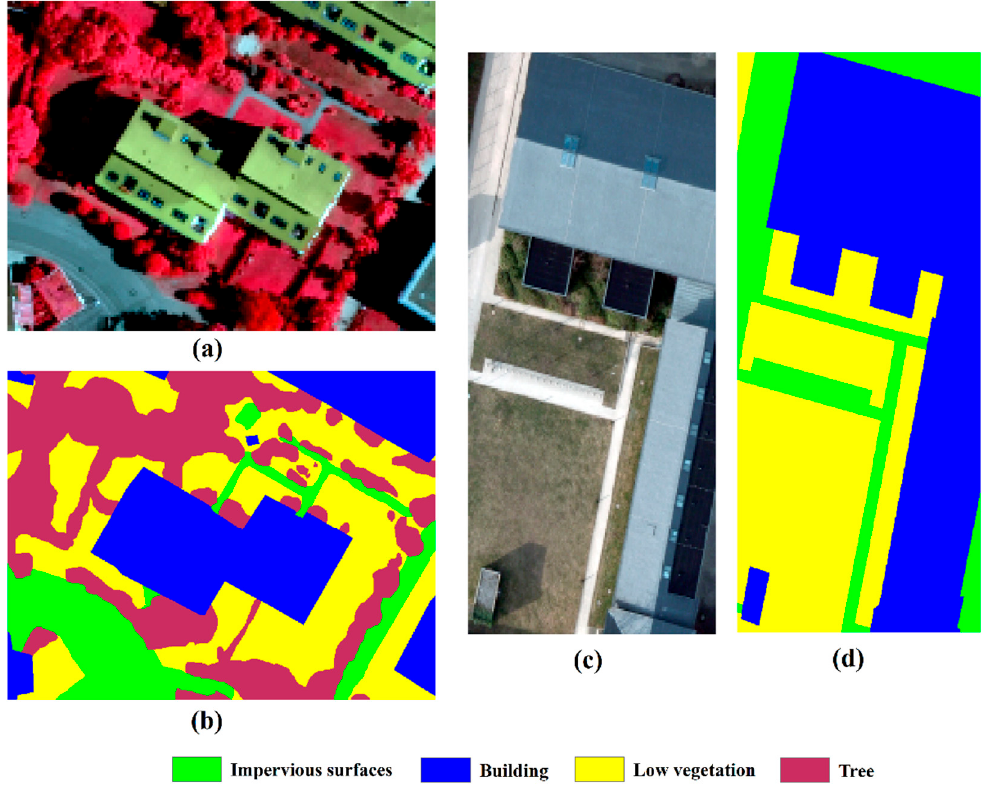
Figure 6. Experimental data: ( a ) false color original Vaihingen image; ( b ) ground truth reference for Vaihingen image; ( c ) true color original Potsdam image; and ( d ) ground truth reference for Potsdam image.